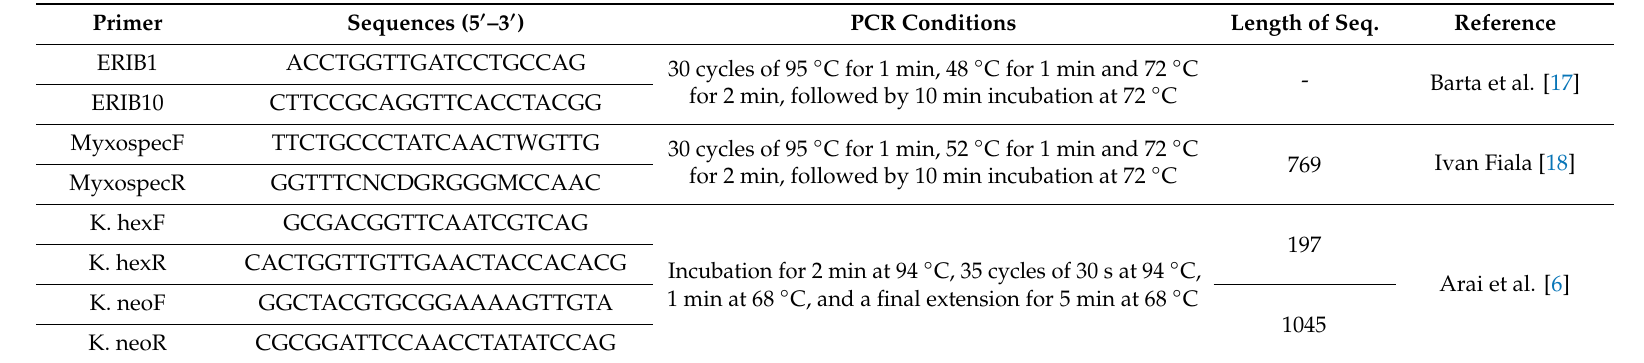
Table 2. Base sequence information and polymerase chain reaction (PCR) conditions of the primer set used in this